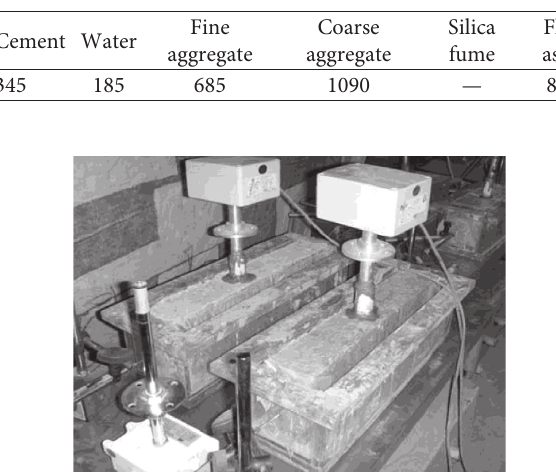
Figure 4: Comparison of simulated data and measured data on points A3 and A4. Table 2: Mix proportion of concrete (kg/m 3 ).